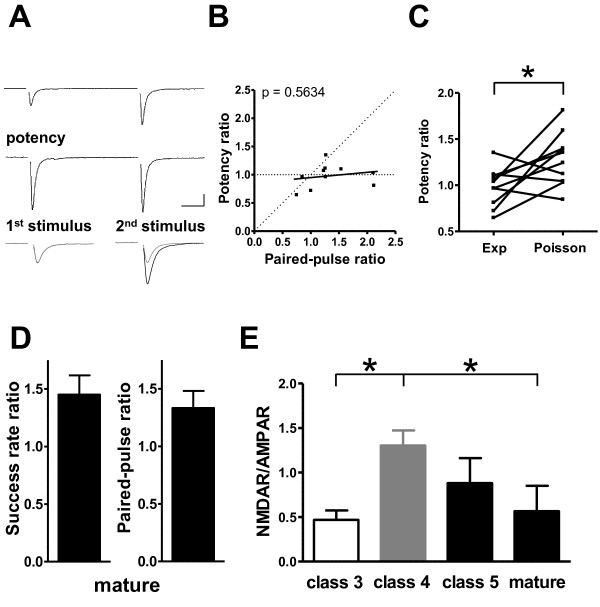
Presynaptic properties of synapses contacting developing and mature GCs. (A) Typical responses to paired-pulse stimulation delivered at the proximal site. Top: Mean responses for the whole dataset (all successes and failures). Middle: Mean potency values for responses to the first and second rounds of stimulation (successful responses only). Bottom: AMPAR-mediated EPSC amplitude and potency. AMPAR-mediated EPSC amplitude for responses to the second round of stimulation, after AMPAR-mediated EPSCs amplitude to first stimulation was scaled (black) to potency for AMPAR-mediated EPSCs amplitude (gray). Scale bar = 10 ms and 10 pA. (B) Paired-pulse ratios for successful responses (left) (ten slices, six mice) and AMPAR-mediated EPSC amplitude (right), recorded from mature GCs (10 slices, six mice). (C) Left: Potency ratio (successful responses only) plotted as a function of AMPAR-mediated EPSCs amplitude ratio (successes and failures) recorded from mature GCs. Most points fell on or near the horizontal dashed line. The linear regression line fitted to all data points is shown in black. P < 0.05 indicates significant deviation of the slope from zero. Right: Comparison between observed (exp) Yes and predicted (Poisson) potency ratios. Predicted values were obtained using a Poisson model. Data were for mature GCs. (D) Ratio of AMPAR-mediated to NMDAR-mediated EPSC amplitude increased during the early developmental stage (class 3 versus class 4, class 4 versus mature; *P < 0.05) (class 3: six slices, six mice; class 4: nine slices, eight mice; class 5: four slices, four mice; mature: six slices, five mice).